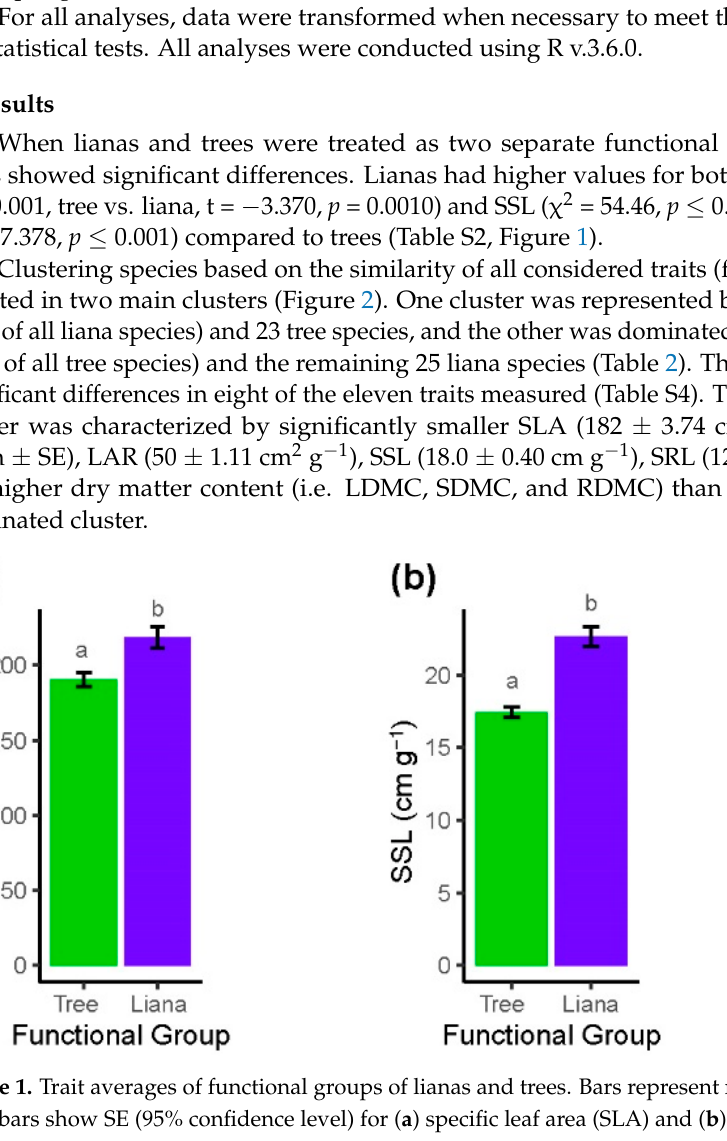
5 Figure 2. Clustering of species by all functional traits. Colors of branches indicate clusters: tree- dominated cluster in dark grey and liana-dominated cluster in brown. Species color indicates tree or liana: trees in green and lianas in blue.